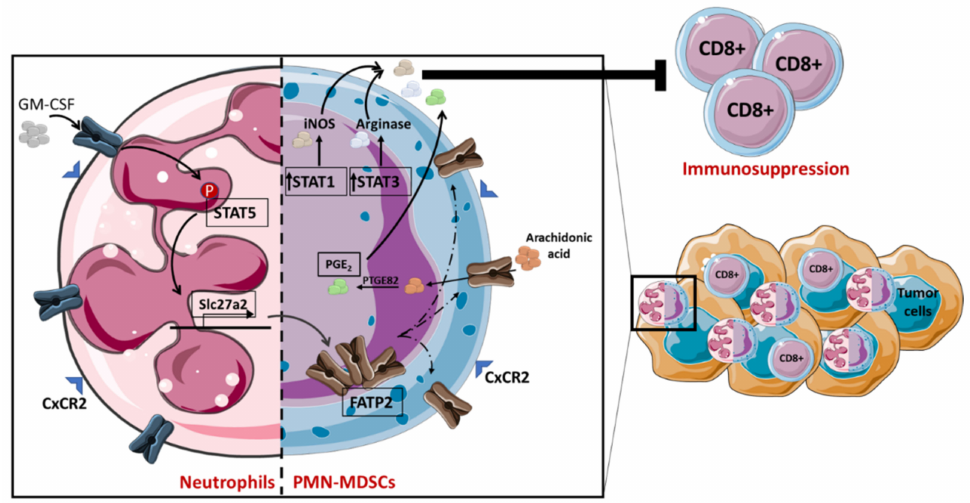
Figure 1. Neutrophils reprogramming to PMN-MDSCs. GM-CSF attaches to the neutrophil re- ceptor, which undergoes gene rearrangement via STAT5 phosphorylation, leading to scl27a2 gene transcription and FATP2 expression. This mechanism leads to the conversion of neutrophils to PMN-MDSCs. Once the reprogramming is complete and FATP2 is attached to the membrane, the PMN-MDSCs will absorb the arachidonic acid, which will be responsible for the synthesis and the secretion of PGE2. The latter, as well as iNOS (produced in response to STAT1 signaling pathway) and arginase (produced in response to STAT3 signaling pathway) will induce the suppression of CD8 T lymphocytes and therefore lead to the proliferation of cancer